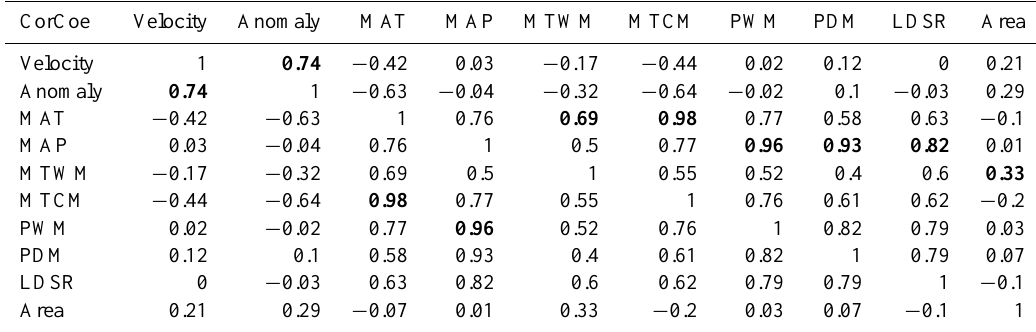
Table A2. Matrix of correlation coefficients (CorCoe)among the 10 environmental variables. The bold value in each column indicates the most correlated variable within that